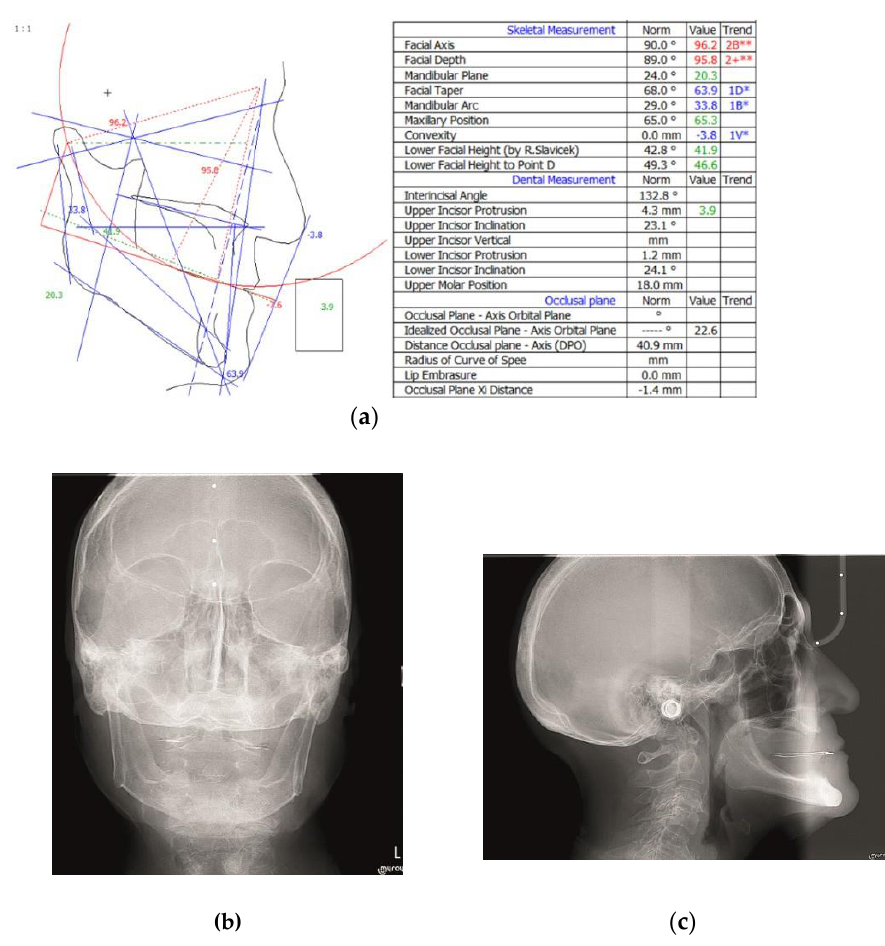
Figure 6. Individual cephalometric study after splint therapy: ( a ) digital cephalometric tracing according to Slaviceck after splint therapy: the new OVD value is within the range of Individual Norm; ( b ) antero-posterior teleradiography (AP Ceph) after splint therapy; ( c ) latero-lateral teleradiography (Lat Ceph) after splint therapy.